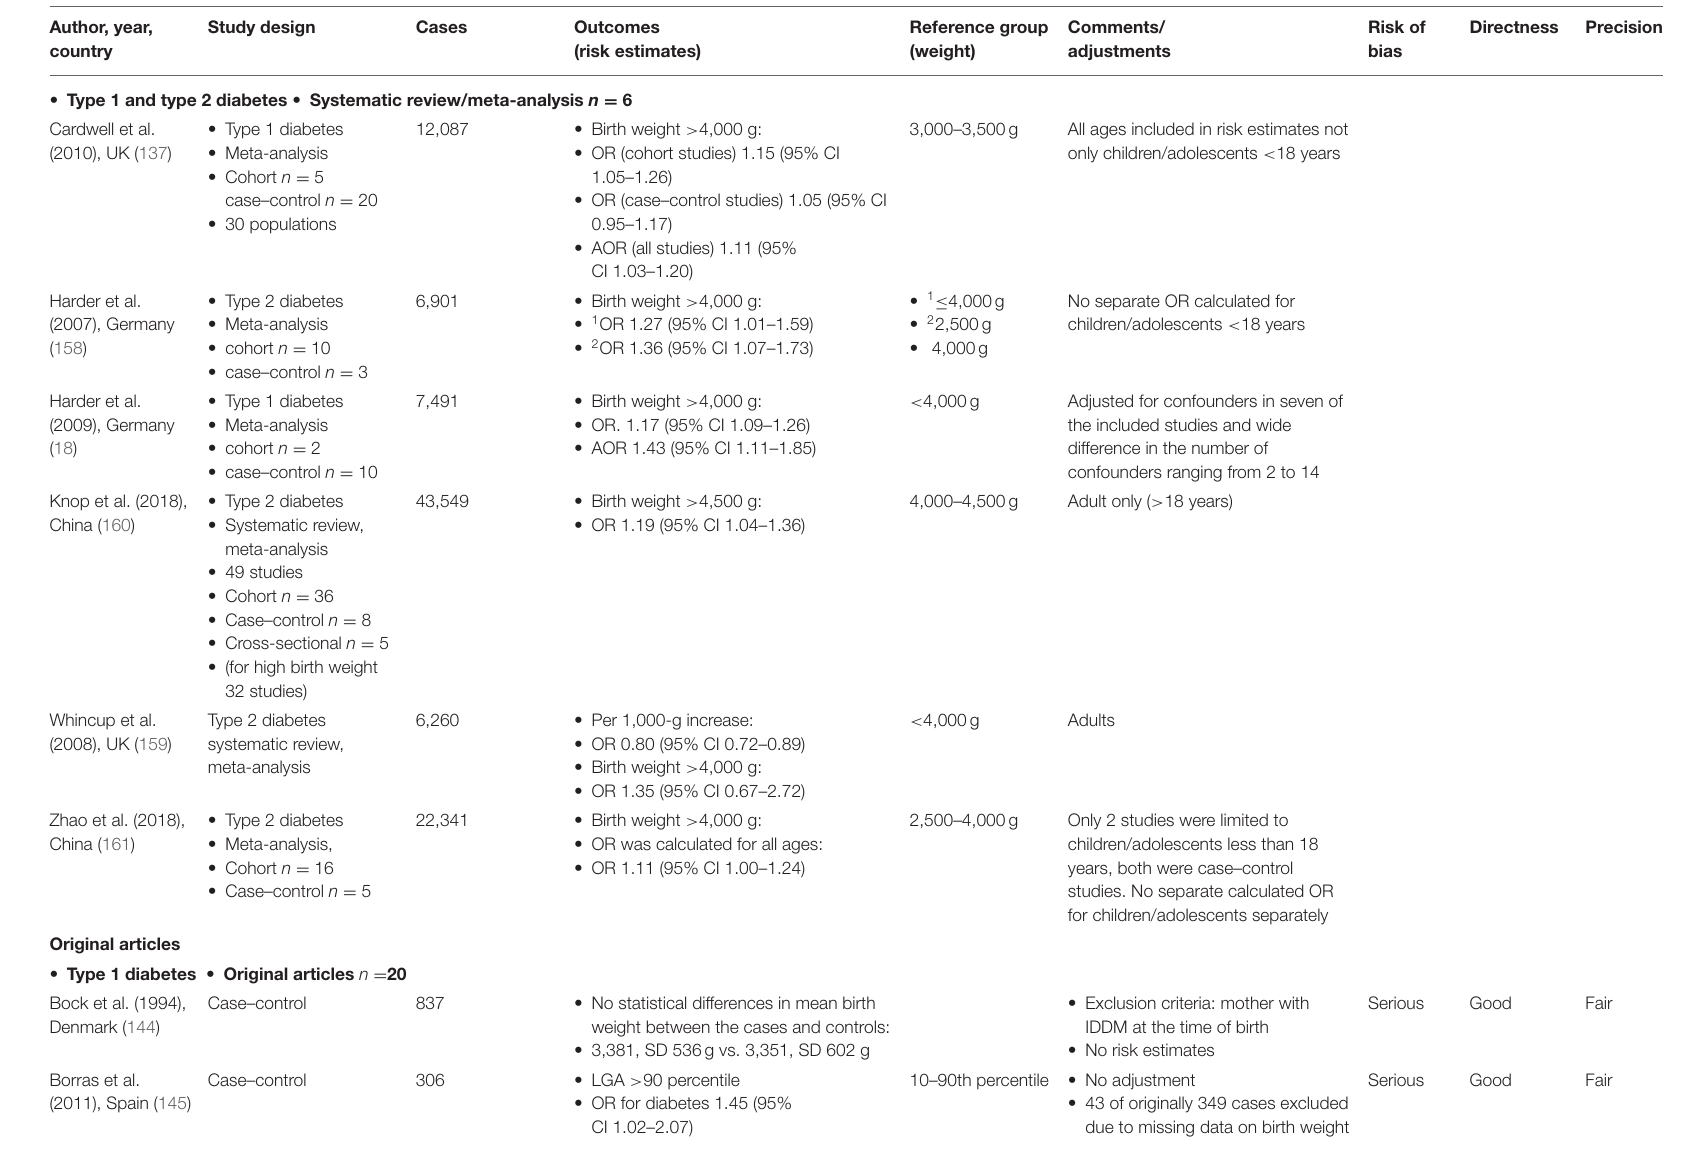
TABLE 1.4 | LGA and high birth weight and long-term outcomes—type 1 and type 2